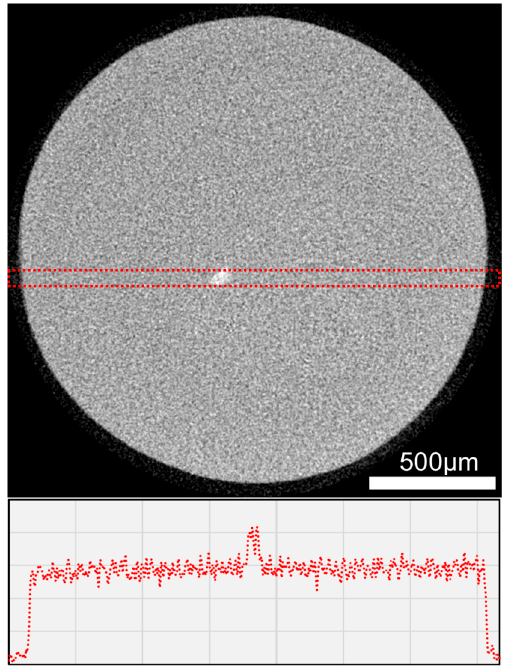
Figure 5. Cross section ( top ) from C E (cylindrical sample) based on µXCT with grey value distribution ( below ) in the region of interest (red dotted rectangle) after storage in hydrochloric acid.